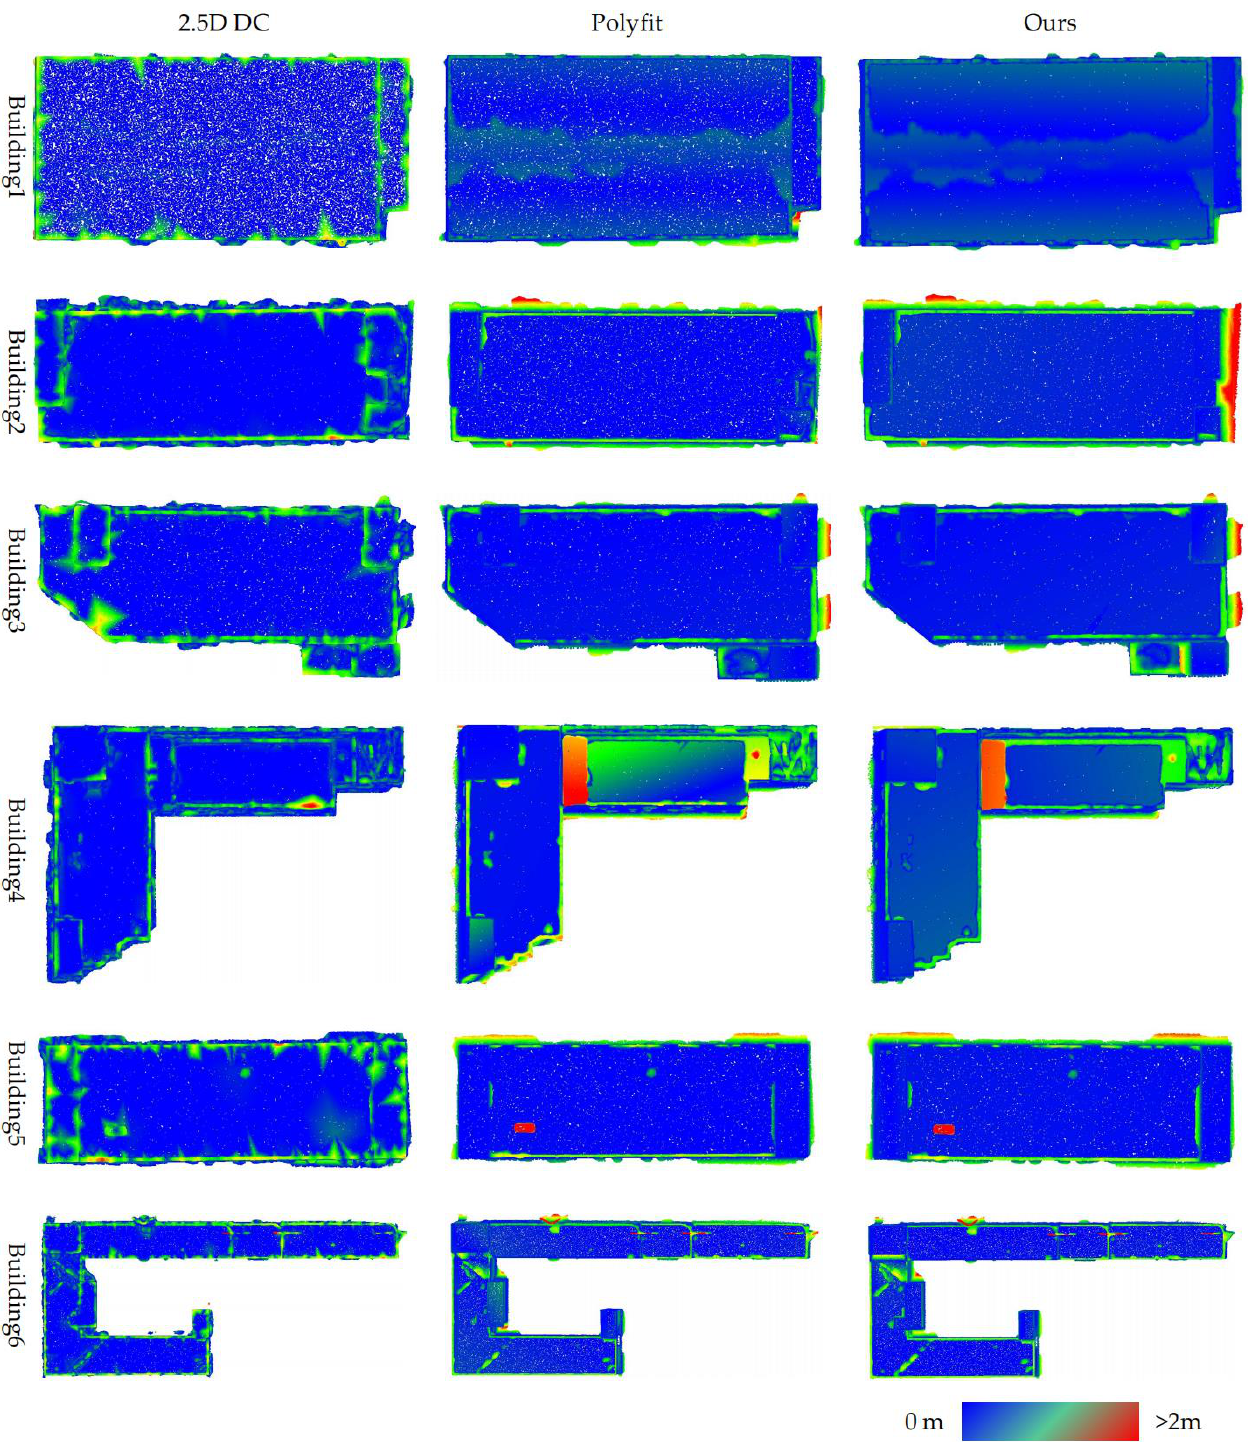
Figure 15. Evaluations of reconstructed Buildings 1 – 6 using the 2.5D DC, PolyFit, and the proposed method. The distance of the point cloud to the model is rendered with color.